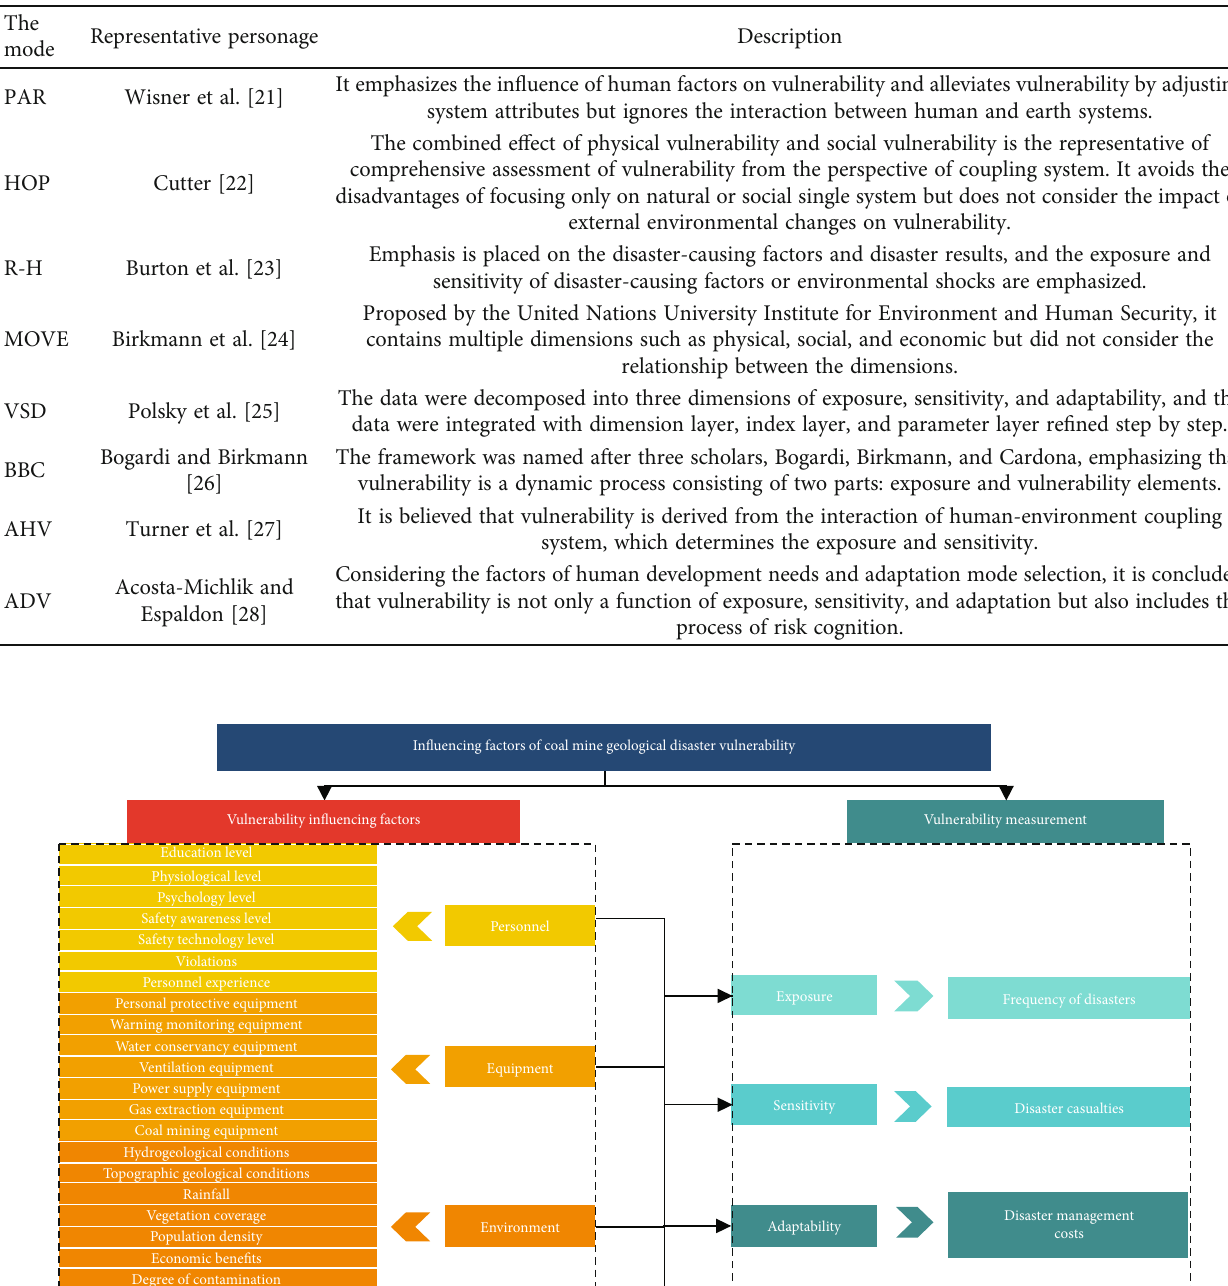
Table 1: Vulnerability framework example.